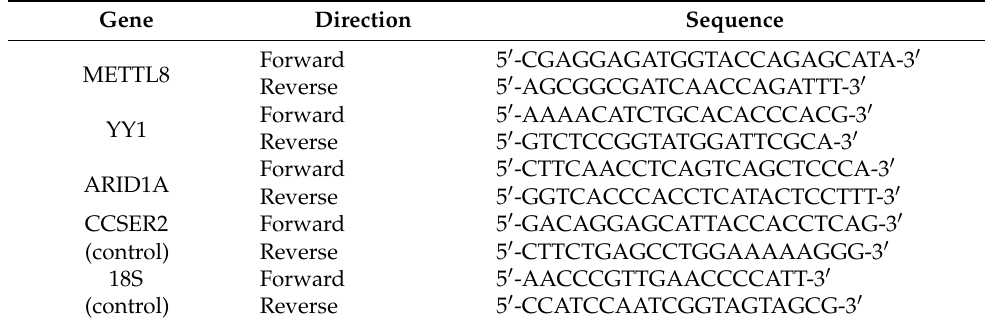
Table 1. Primers for RT-qPCR